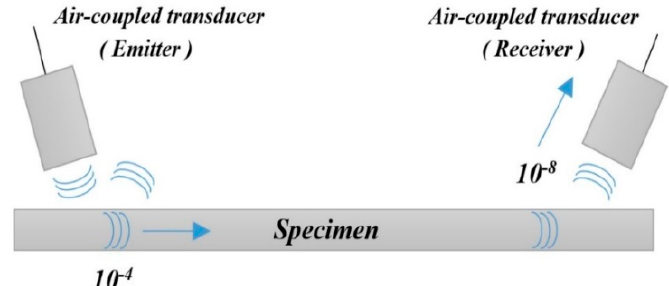
Figure 8. Transmission in air using two air-coupled transducers. Values shown are approximate fractions of the original energy.